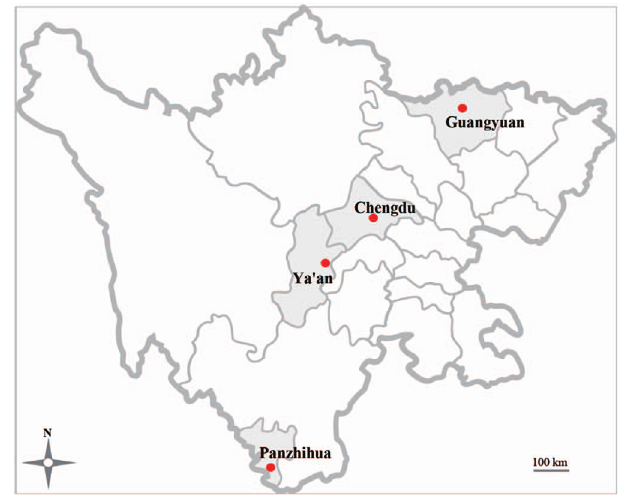
Figure 1. Geographical distribution of the sampled cities ( fi lled red dot) in Sichuan